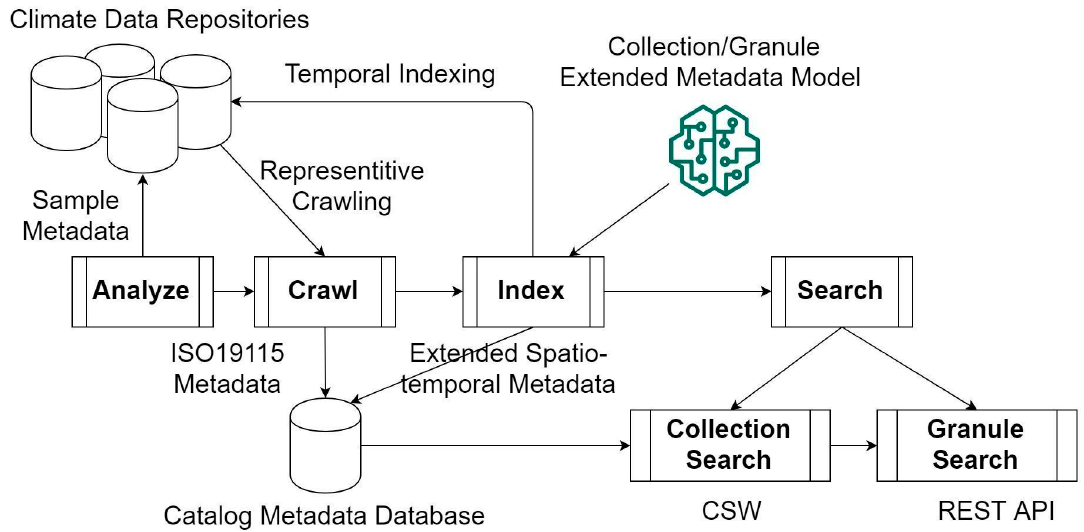
Figure 1. The proposed big climate data cataloging solution. Abbreviations: CSW, Catalog Services for the Web; REST API, Representational State Transfer Application Programming Interface.